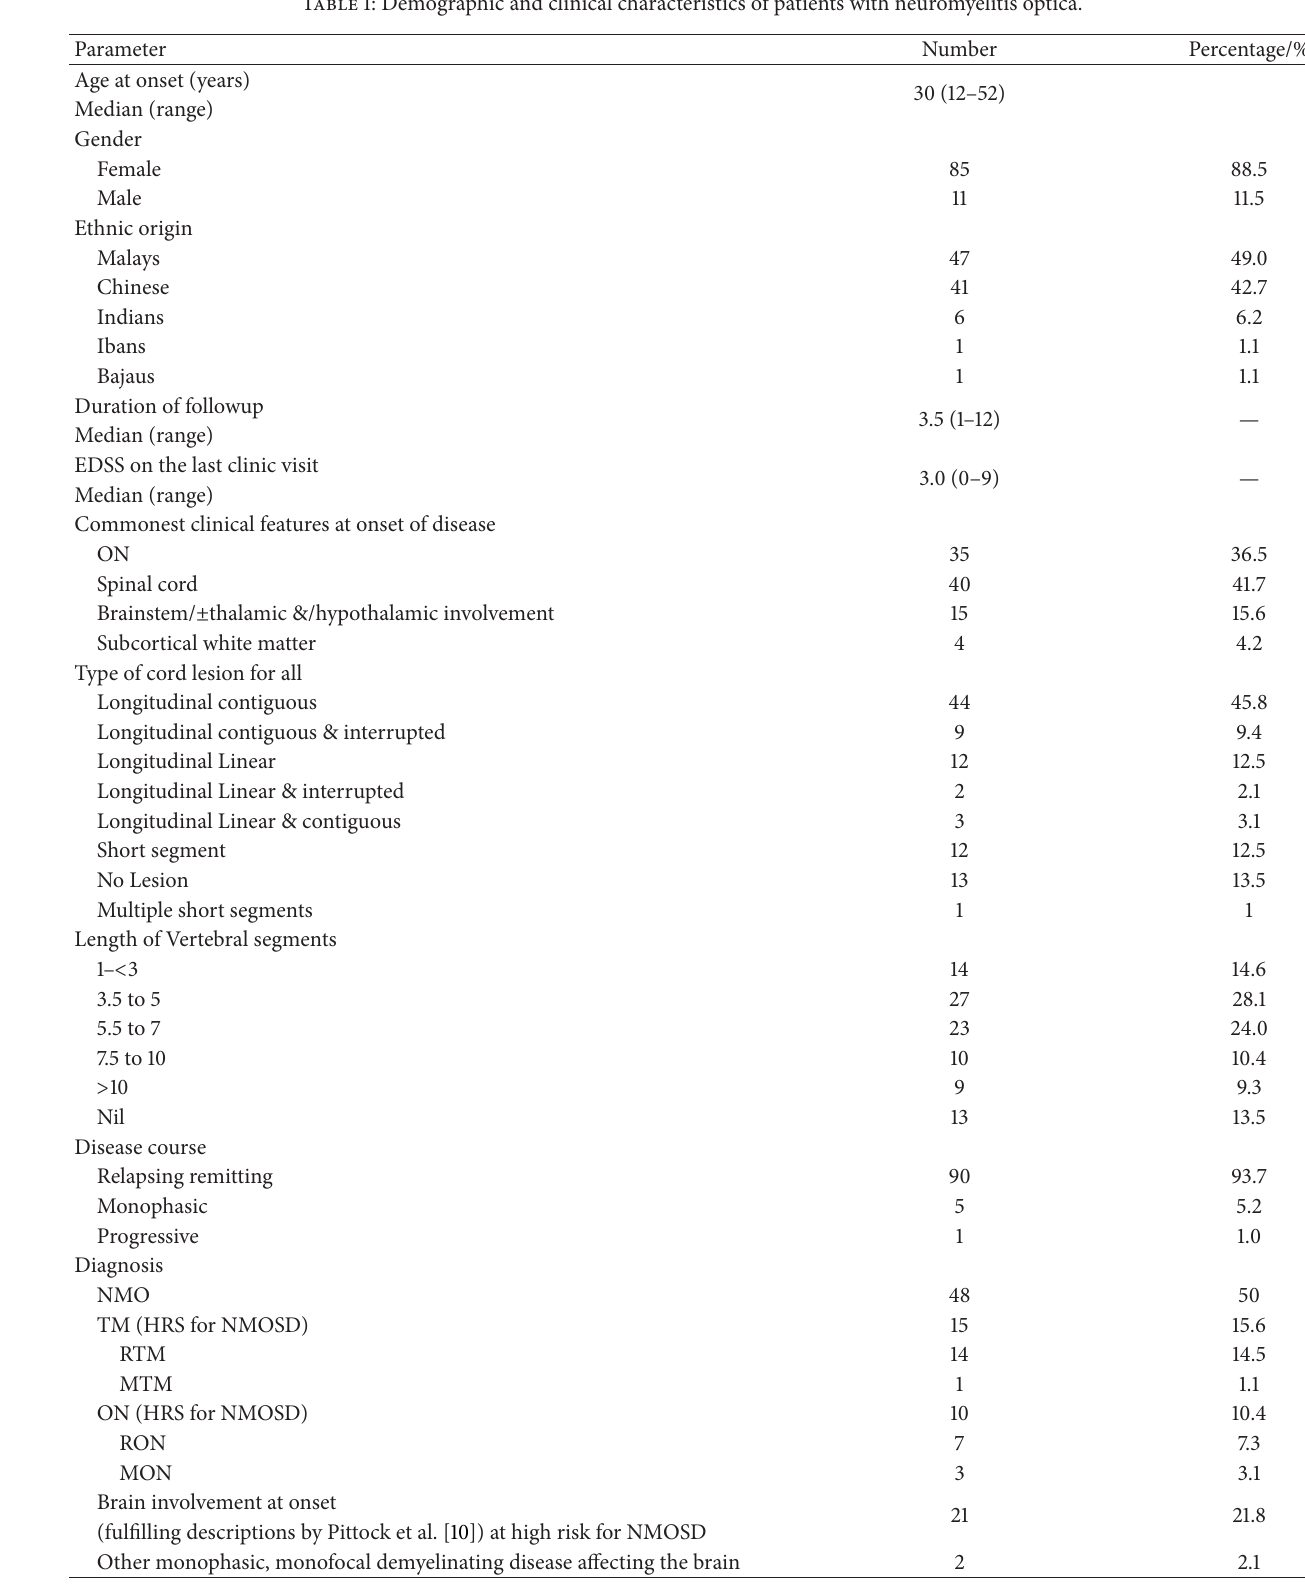
Table 1: Demographic and clinical characteristics of patients with neuromyelitis